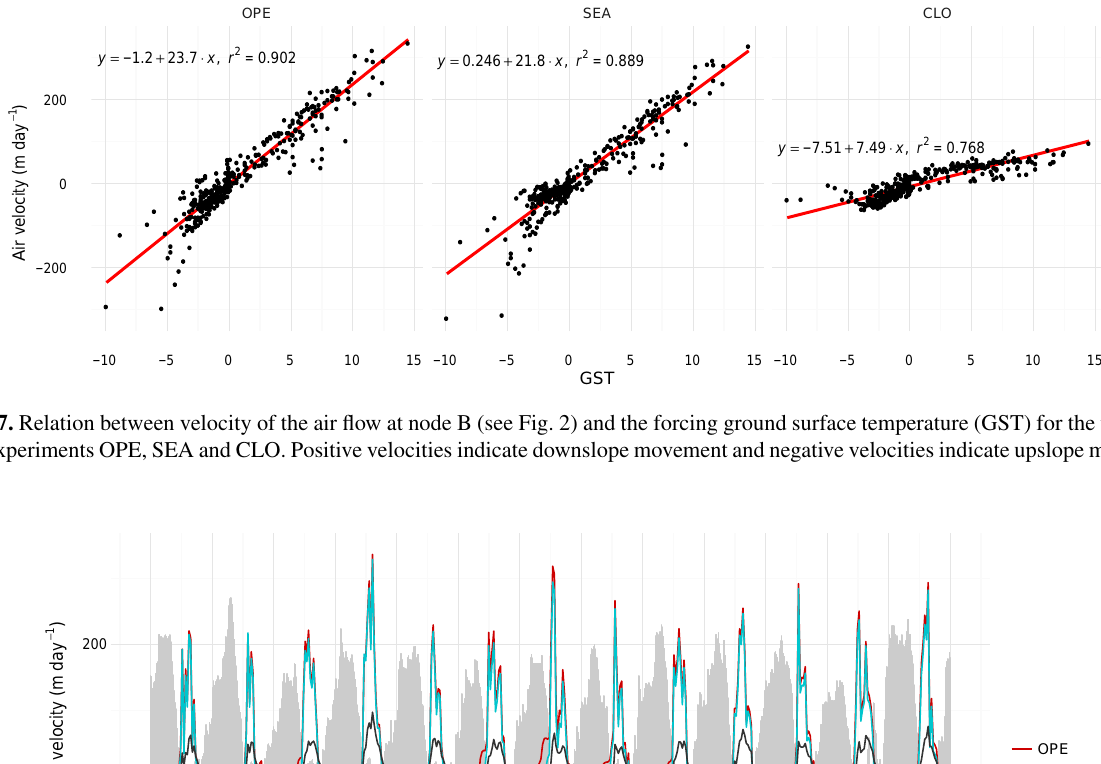
comparatively flat rock glacier with large furrows and